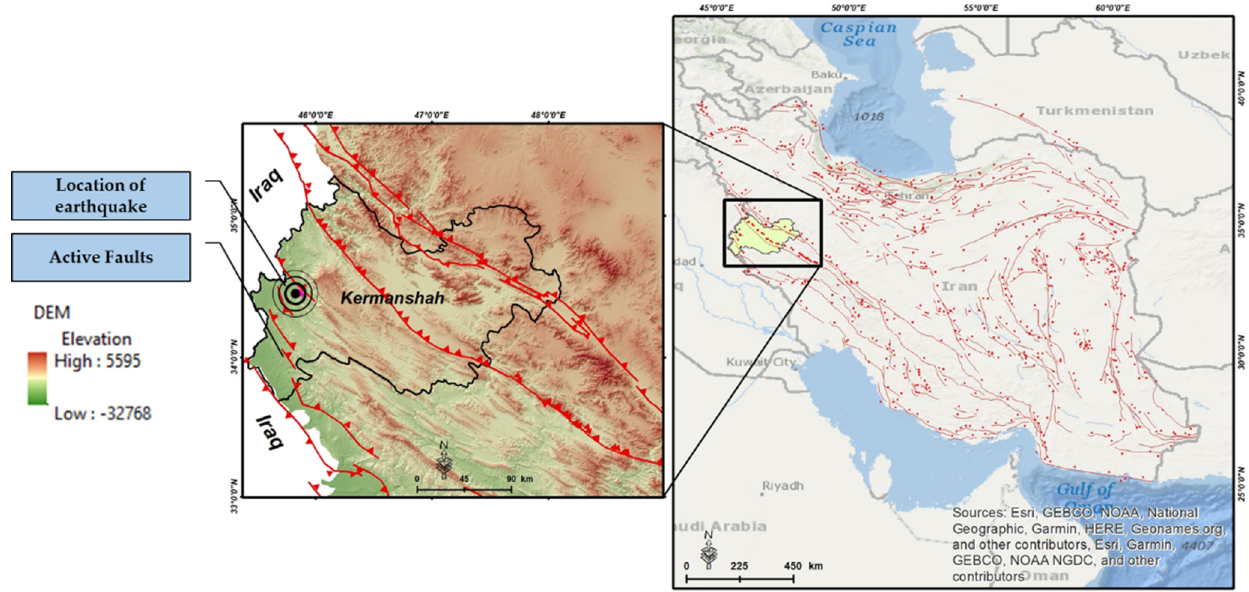
Figure 2. Location of earthquake and active faults in the study area.